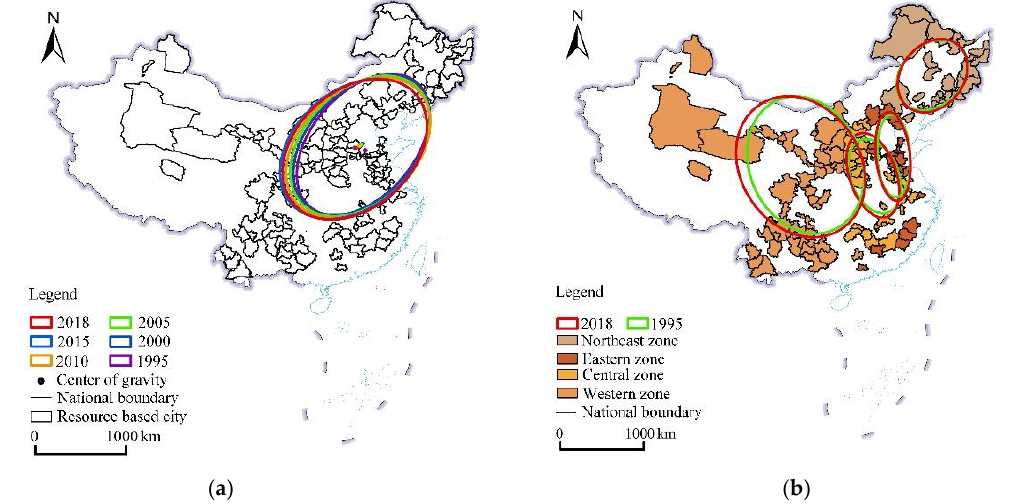
Figure 7. Standard deviation ellipse results for construction land in RBCs (1995 – 2018). ( a ) Standard deviation ellipse; ( b ) standard deviation ellipse in different regions. Table 1. Standard deviation ellipse analysis results.